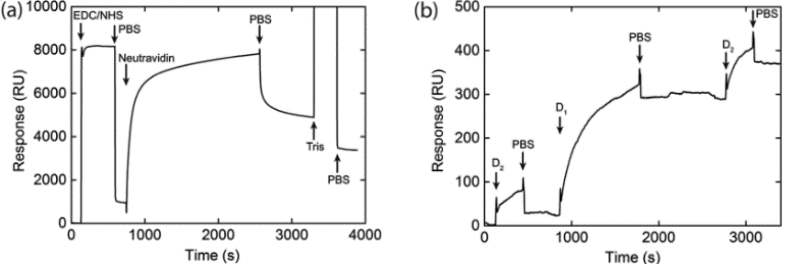
Figure 12. ( a ) Covalent immobilization of neutravidin on the surface of the graphene oxide (GO) linking layer deposited on the copper surface plasmon resonance (SPR) sensor chip protected by 15 nm thick Al 2 O 3 film. The immobilization procedure includes the activation of carboxyl groups of GO by the mixture of 0.4 M 1-ethyl-3-(3-(dimethylamino) propyl) carbodiimide hydrochloride (EDC) and 0.1 M N-hydroxysuccinimide (NHS) solutions and deactivation of carboxyl groups after neutravidin adsorption by 1 M Tris solution. ( b ) Adsorption of oligonucleotides D1 and D2 on the surface of neutravidin–GO copper SPR chip. D1 is biotinylated and complementary to